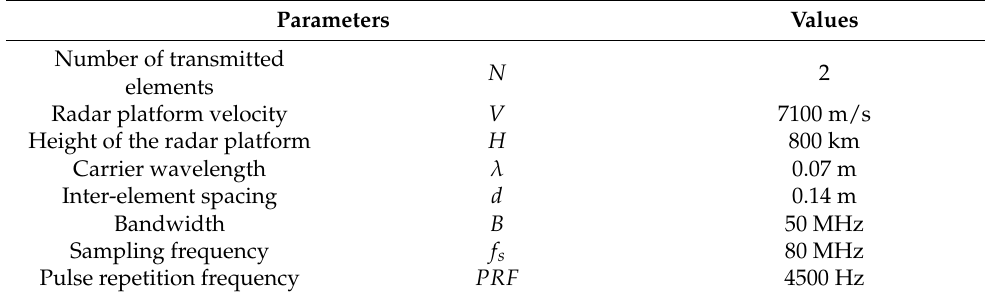
Table 1. Parameters for the spaceborne SAR